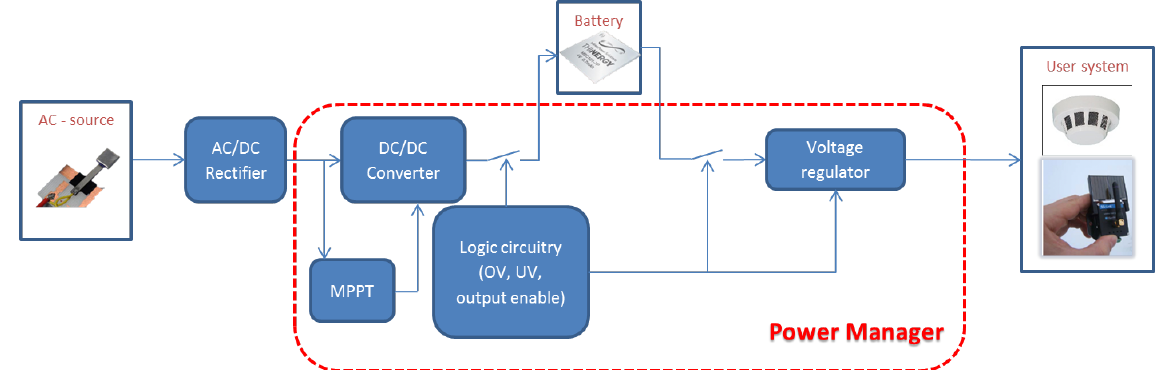
Figure 29. Typical schematic diagram of a power